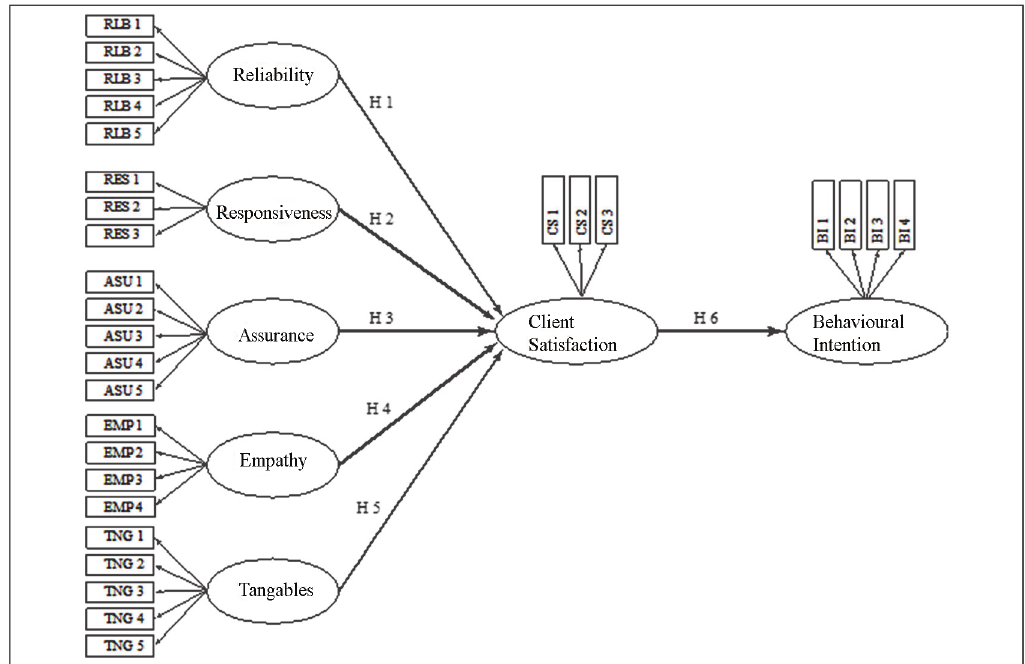
Figure 1. Research framework of the